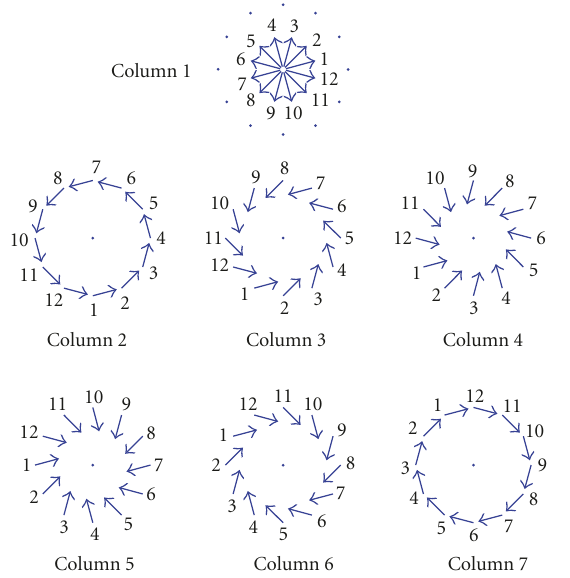
Figure 1: Locations and orientations of the DTCWT coe ffi cients. Each orientation describes a coe ffi cient, or conjugate, of one of the six subbands. The column numbers indicate the column of the P -matrix in which the coe ffi cients are placed, and the numbers displayed around each circle indicate the row of the P -matrix that each coe ffi cient is placed. Taken from [4].